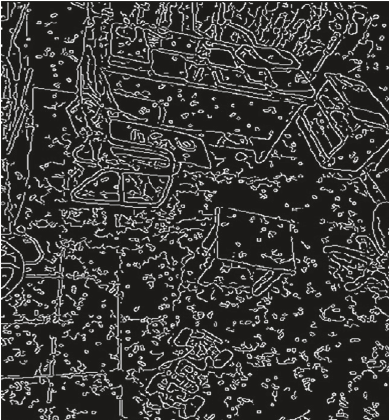
Figure 21: The tested